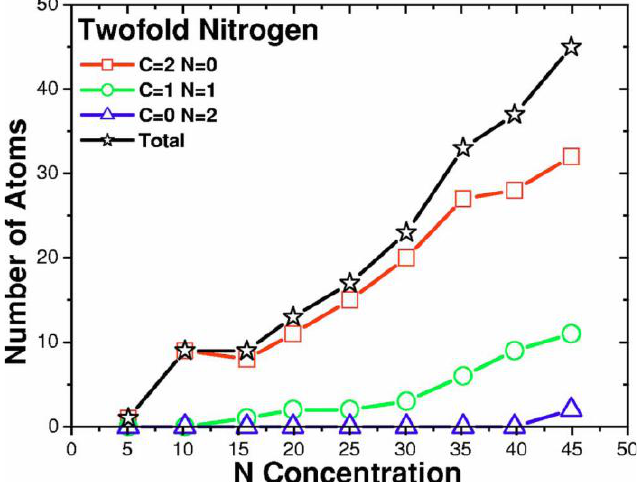
Figure 16. Nitrogen double bonded. The total number is practically zero at 5%, shows a plateau between 10% and 15% and increases systematically afterwards. Squares represent nitrogens bonded to two carbons and circles to one carbon and one nitrogen.